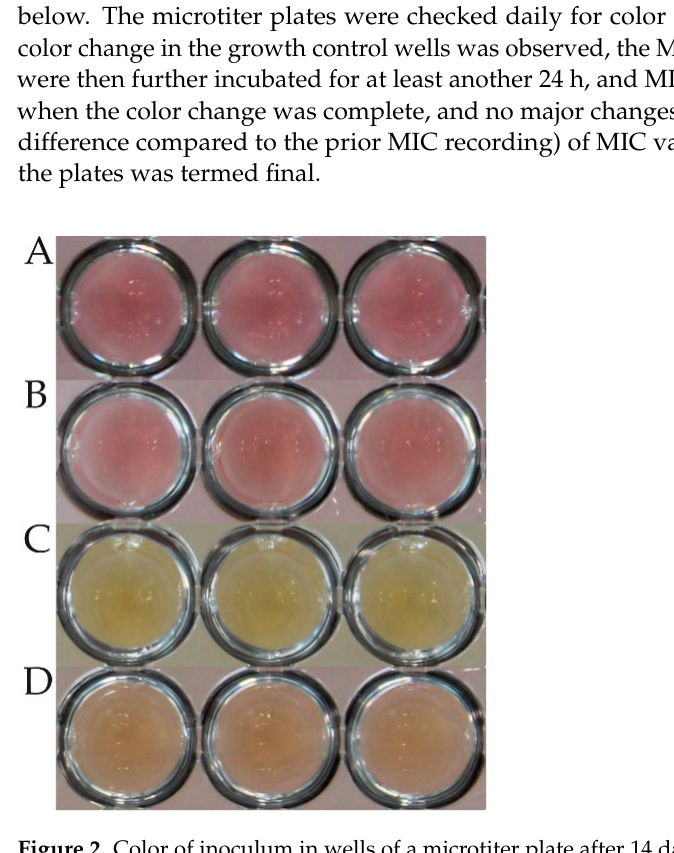
Figure 2. Color of inoculum in wells of a microtiter plate after 14 days of incubation. All plates were incubated at 37 °C and ambient air. ( A ) modified Friis broth without mycoplasmas ( B ) M. hyorhinis DSM 25591, no visible growth and no color change (red). ( C ) M. hyorhinis DSM 25591, visible growth indicated by complete color change (yellow). ( D ) M. hyorhinis DSM 25591, trailing with incomplete color change (orange).